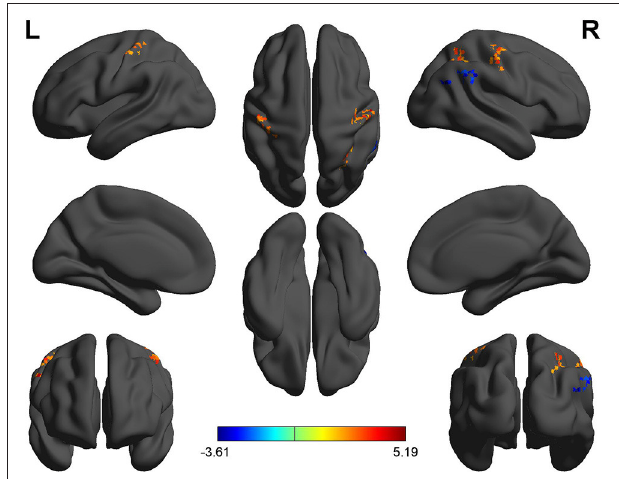
FIGURE 5 | Binarized longFCD differences between SD and RW. The color in the map represents the differences. The red color signifies increased binarized longFCD in brain areas, and the blue signifies decreased binarized longFCD in brain areas. longFCD, long-range functional connectivity density; SD, Sleep deprivation; RW, Rested wakefulness; L, left; R,